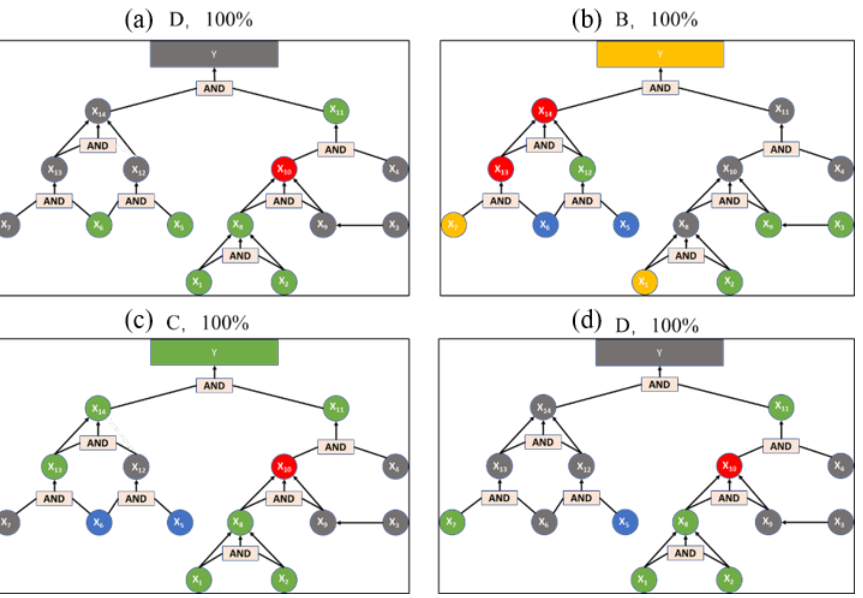
Figure 9. Partial training results of initial dataset. ( a ) and ( d ) indicate these two spare parts are 100% classified into class D; ( b ) shows this spare part is 100% classified into class B; ( c ) shows this spare part is 100% classified into class C.